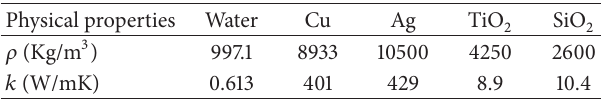
Table 1: Physical properties of water and nanoparticles under consideration [25].